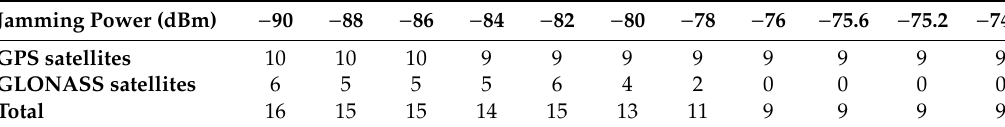
Table 7. Minimum number of available satellites for scenario #5.